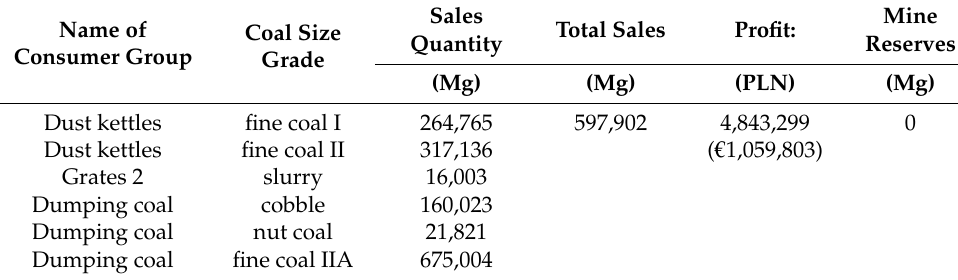
Table A4. The optimal production and sales plan for mine “A” for 2021.